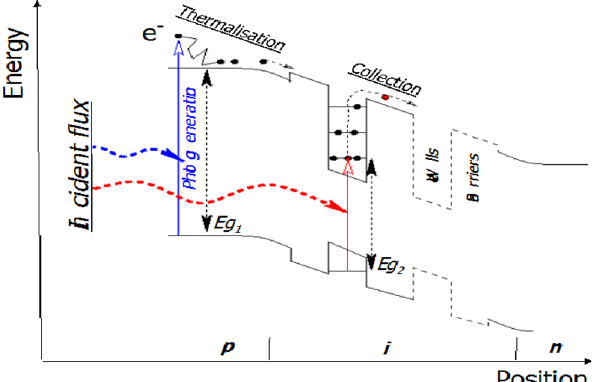
Fig. 1. Schematic representation of a p-i-n quantum well solar cell (QWSC) showing generation in well and barriers regions, thermalisation, collection, and